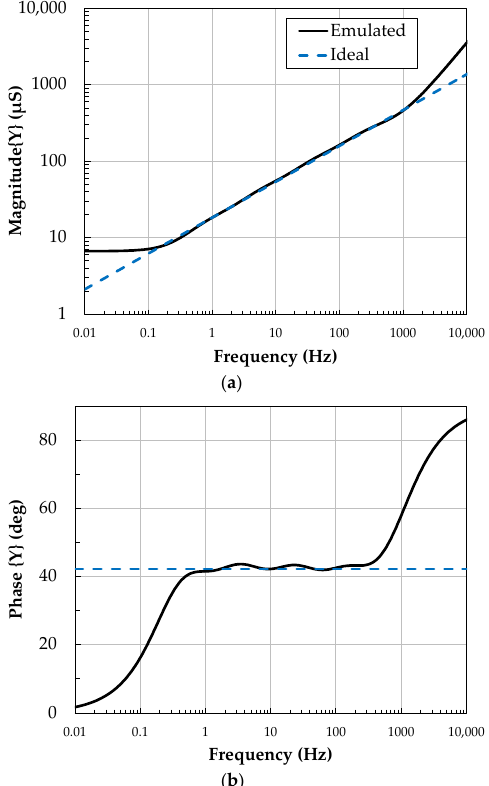
Figure 16. Admittance magnitude ( a ) and phase ( b ) characteristics of the approximated FO capacitor from Figure 15.